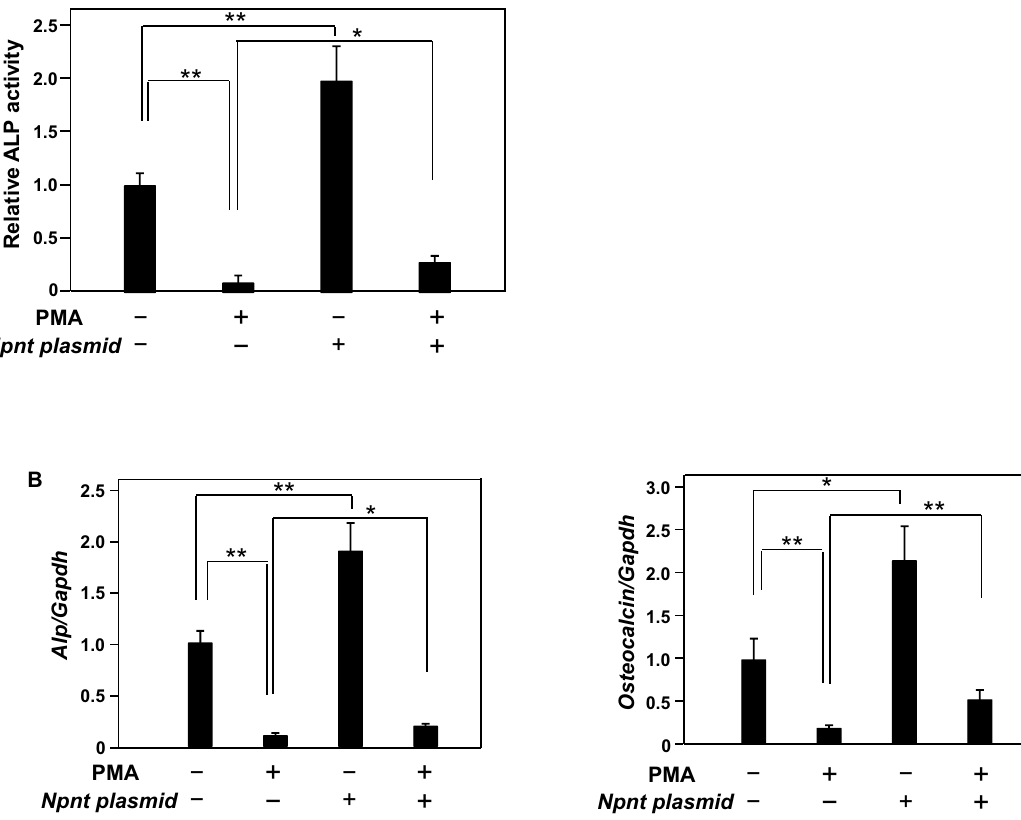
Figure 2. MC3T3-E1 cells with over-expression of Npnt were treated with PMA (10 nM). ( A ) For quantification of ALP activity, cells were disrupted by sonication in 50 mM Tris–HCl containing 0.1% NP40, then the activity was determined following incubation with the substrate p-nitrophenylphosphate using absorbance at 405 nm. ( B ) Total cellular RNA was extracted, then mRNA levels of Alp, Osteocalcin , and Gapdh were examined using quantitative real-time PCR analysis. Results are shown as the mean ± SD of three samples. ** P < 0.01 and * P < 0.05, Student’s t